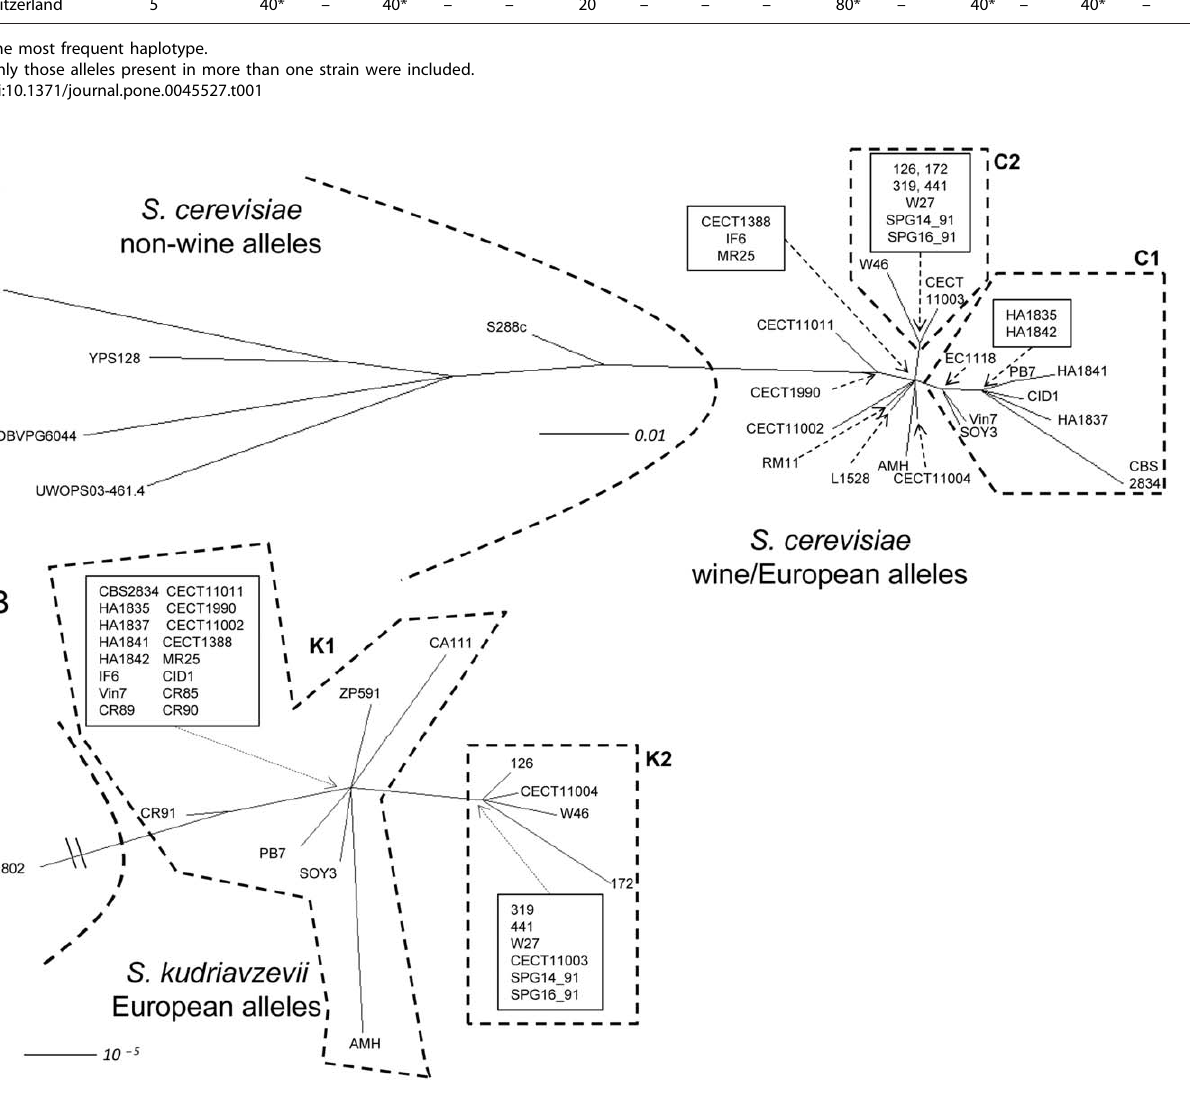
Figure 2. Supernetworks obtained using data from seven nuclear genes ( BRE5 , CAT8 , CYC3 , CYR1 , EGT2 , GAL4 and MET6 ) for both Saccharomyces cerevisiae (A) and Saccharomyces kudriavzevii (B) alleles from hybrids, from reference S. cerevisiae [ 9,24 ] and S. kudriavzevii strains. Scale bar represents the edge’s weights inferred using the tree size weighted means options, a measure similar to those from branches in a phylogenetic